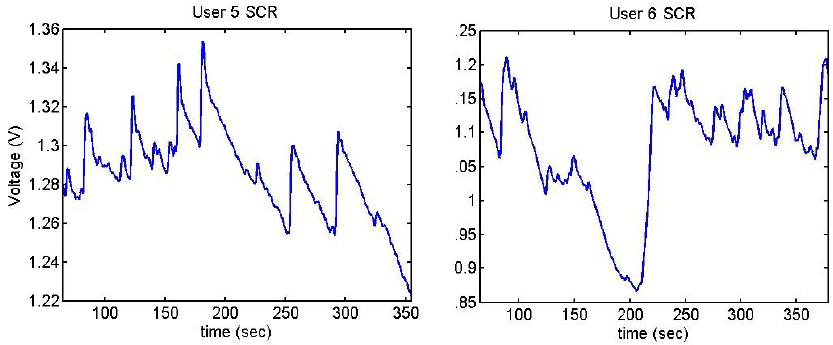
Figure 34. Skin response of users 5 and 6 from Sounds Test.